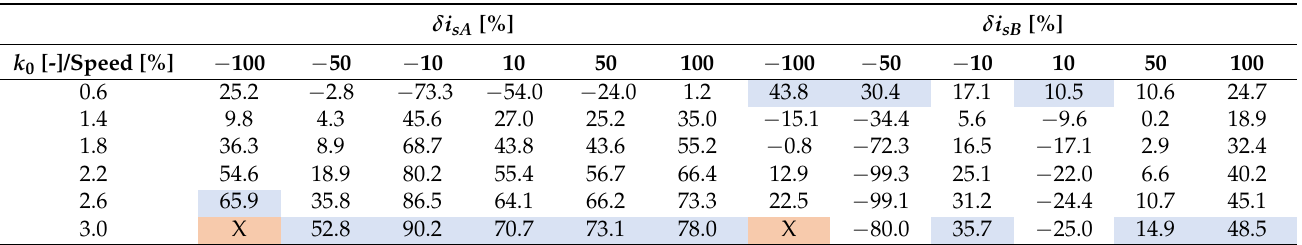
Table 6. Decrease in MLO sensitivity to changes in IM parameters relative to OLO, for a faulty CS in phase B (grey color indicates the best